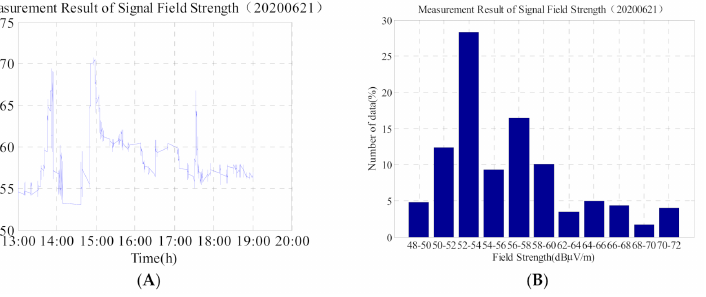
Figure 6. ( A ) Field strength change of low-frequency time-code signal on 21 June 2020 (the day of the annular eclipse) and ( B ) corresponding histogram. Total number of data is 2413.